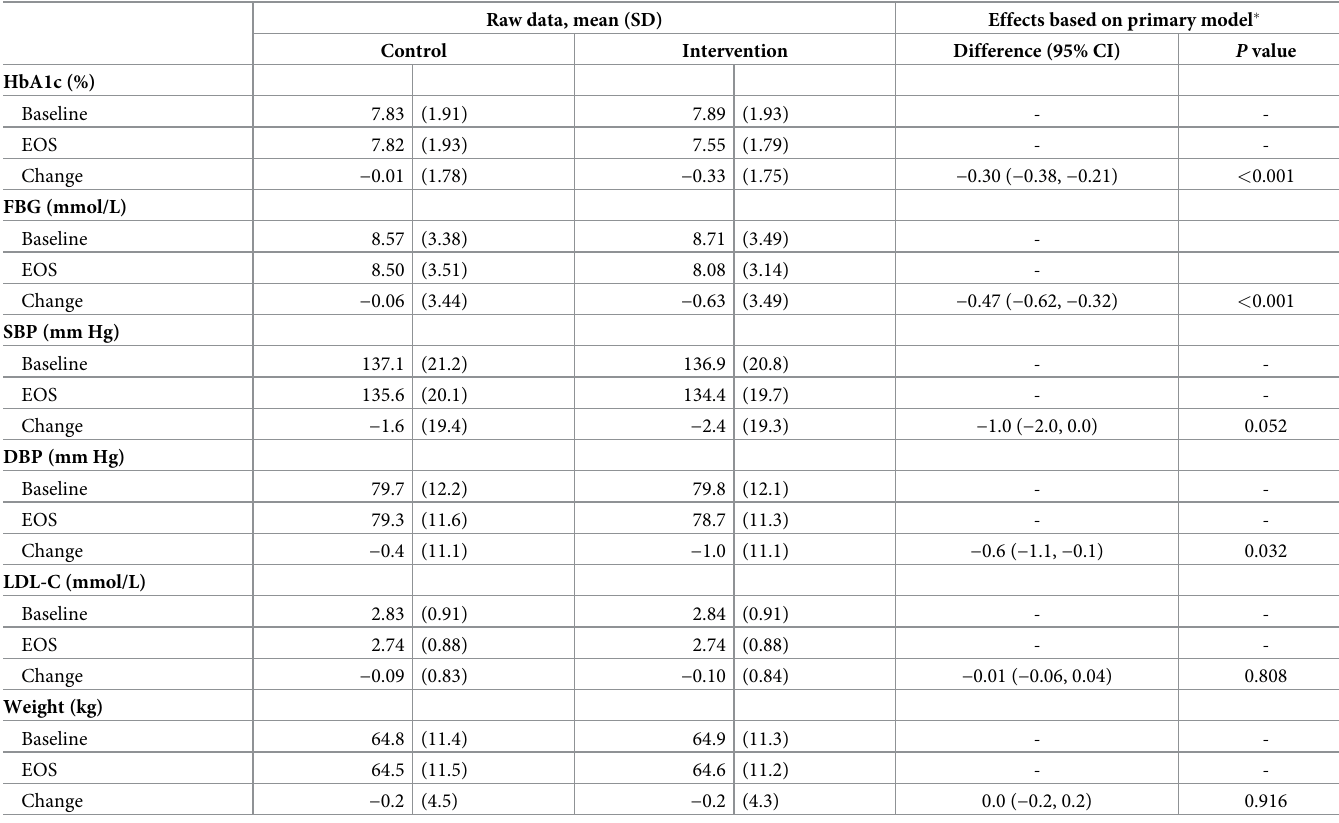
Table 3. Estimated effects of intervention compared with control on primary and secondary outcomes, with continuous